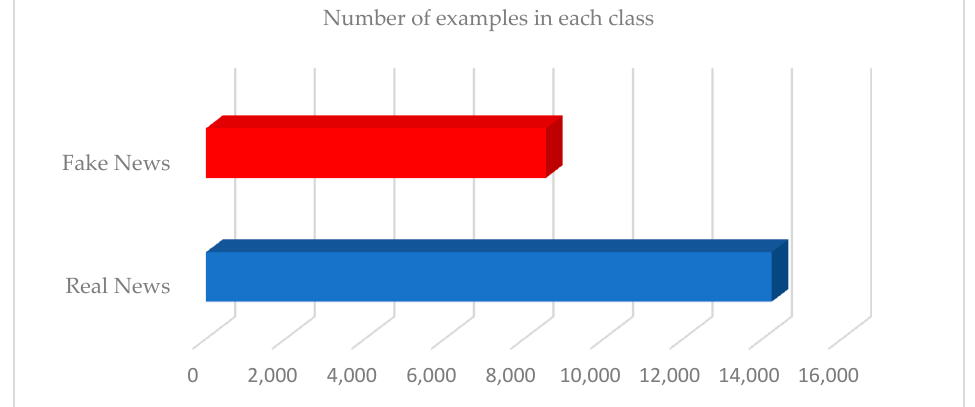
Figure 5. The size of the Fakeddit dataset.